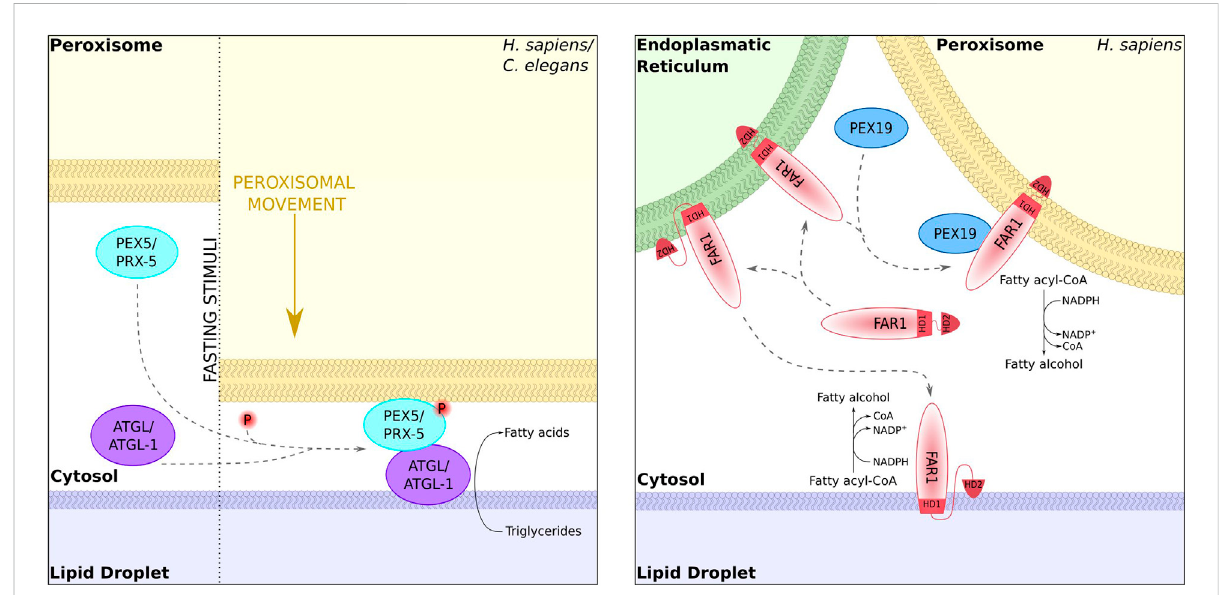
FIGURE 4 Dual targeting to peroxisomes and lipid droplets. The lipases ATGL-1 ( Caenorhabditis elegans ) and ATGL (mammalian cells) can target lipid droplets in a Pex5-dependent manner at sites of organelle contact [left; Kong et al. (2020)]. The fatty acid reductase Far1 is dually localized to peroxisomes and lipid droplets. Localization to one or the other organelle requires different topologies of the hydrophobic domains [right; Exner et al.